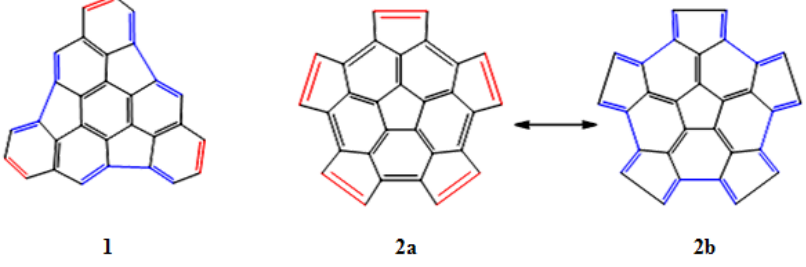
Figure 2. Regions in which the fragments 1 and 2 behave as a diene (blue color), or as a dienophile (red color).